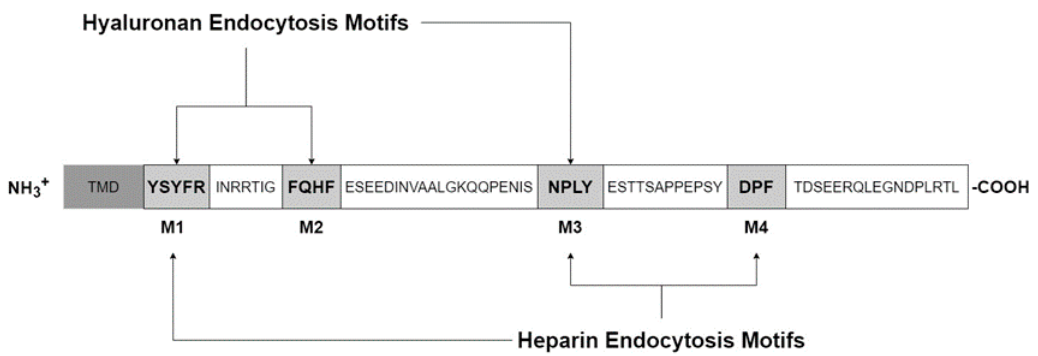
Figure 3. The cytoplasmic domain of Stabilin-2/HARE.